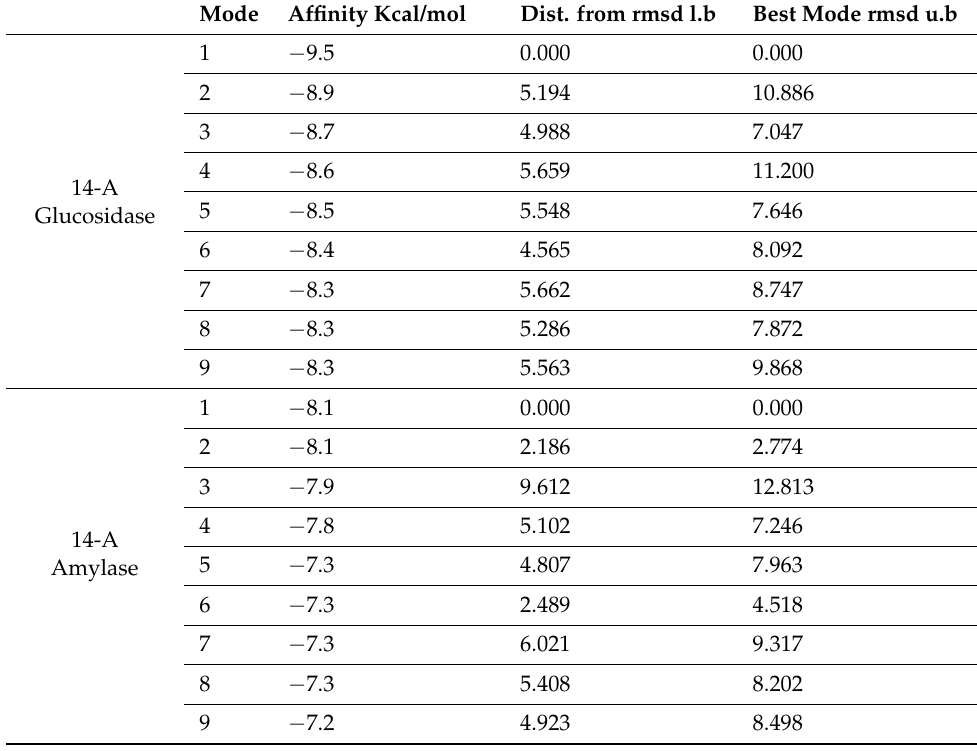
Table 3. Showed nine different poses of analogue 14 with varied binding